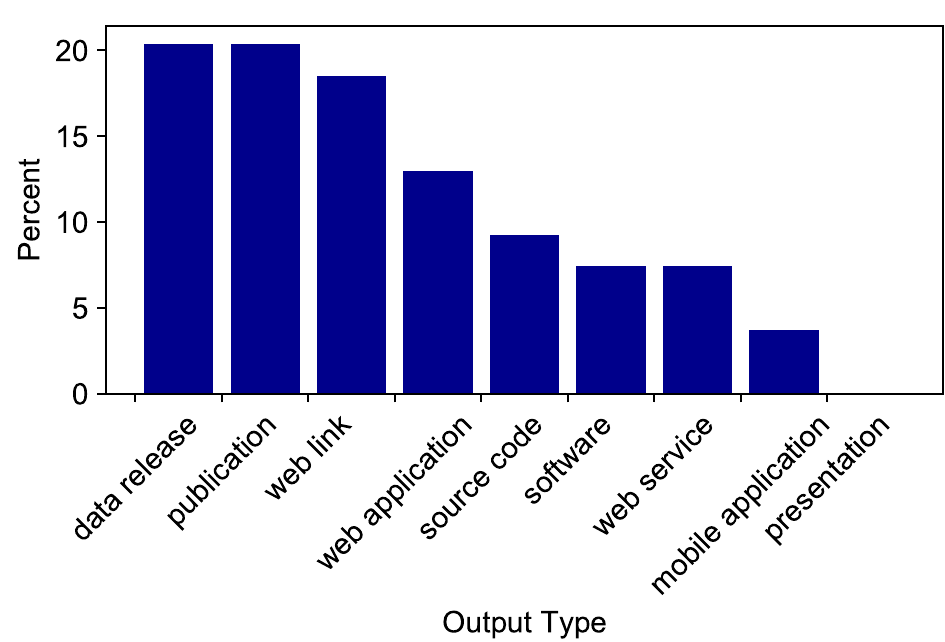
Fig 2. Percentage of CDI Project outputs proposed but not delivered, by type. Values shown are output types, expressed as a percentage of the 54 outputs that were proposed but not delivered.